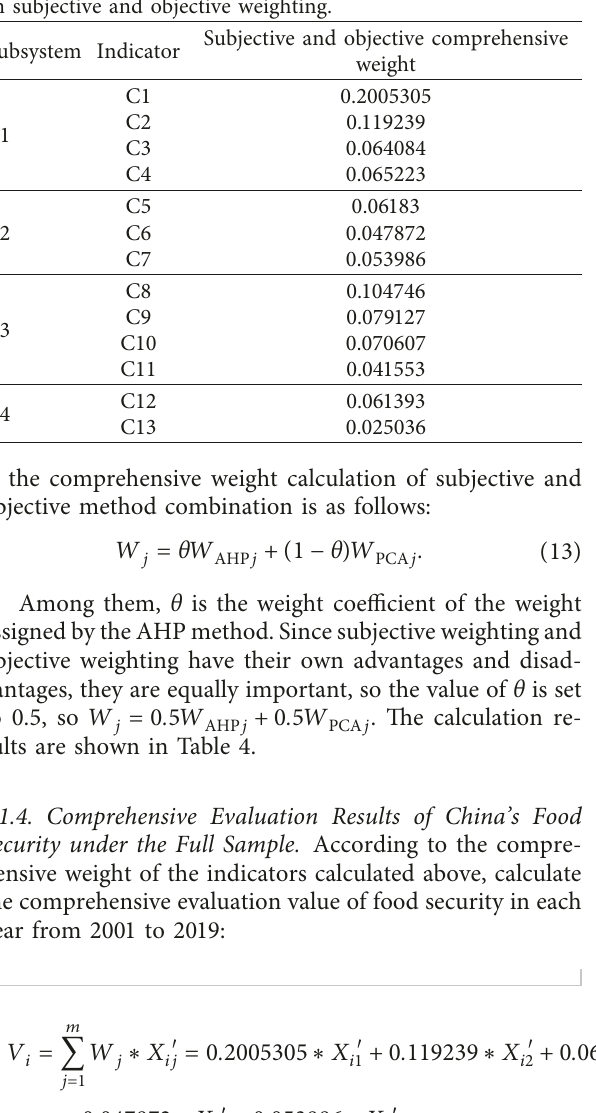
Table 5: Comprehensive evaluation results of food security in